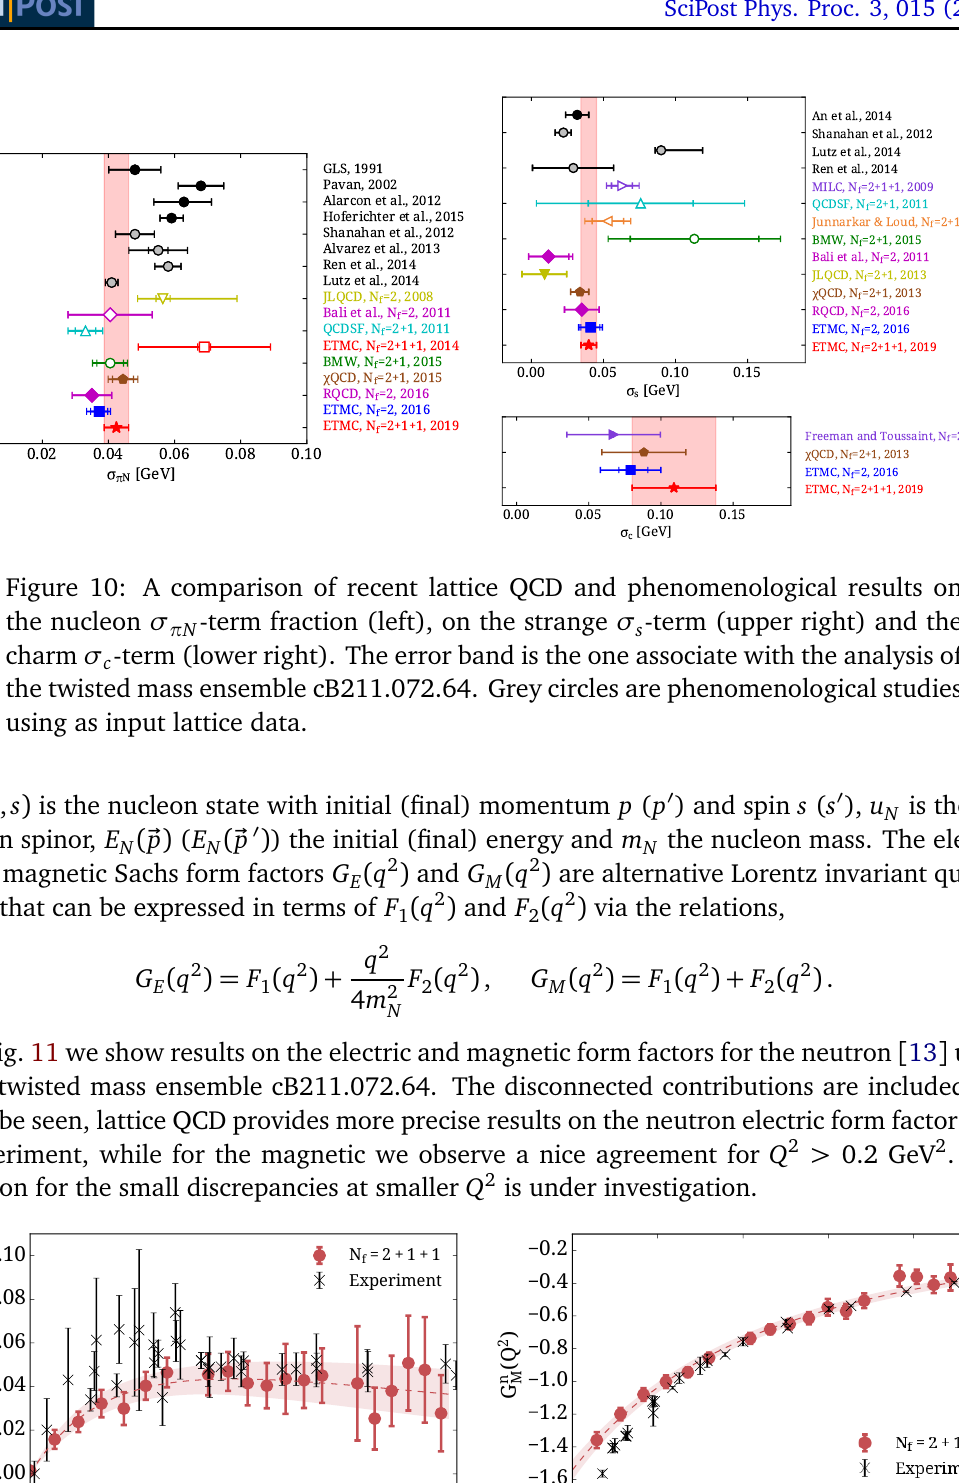
Figure 11: Neutron electric (left) and magnetic (right) form factors as a function of Q 2 . Filled circles show the lattice QCD results obtained using the cB211.072.64 ensemble [ 13 ] and black crosses are experimental results (see Ref. [ 13 ] for the the detailed bibliography on the experimental results). The fits to lattice QCD results use the Galster-like form for the electric form factor and a dipole form for the